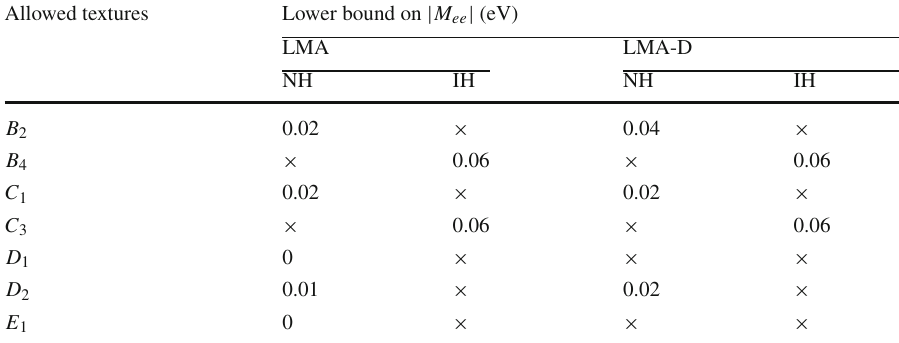
Table 7 3 σ lower bound on effective Majorana mass ( | M ee |